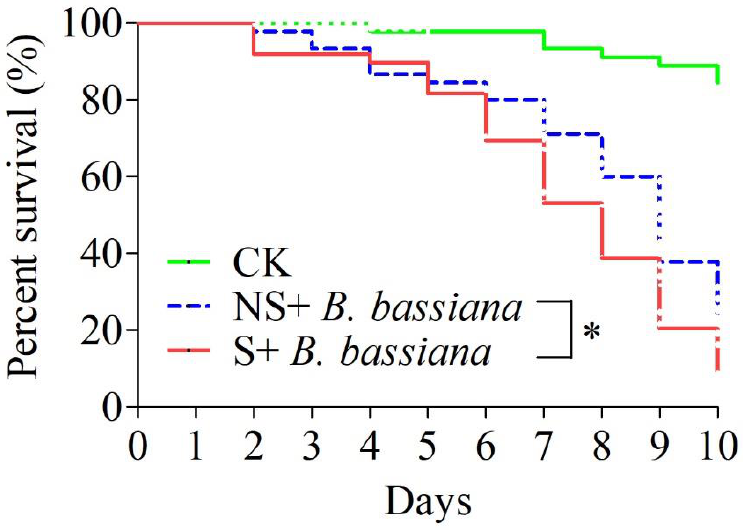
Figure 1. Effect of surface disinfection on survival of Locusta migratoria treated with Beauvaria bassiana strains (BbZJ1). CK = group of Locusta migratoria treated with 0.05% Tween-80. NS = no sterilization and S = sterilization. The log-rank (Mantel–Cox) test method in GraphPad 5 software was used to analyze the differences among the survival curves. “*” Significantly different at 0.05 level.